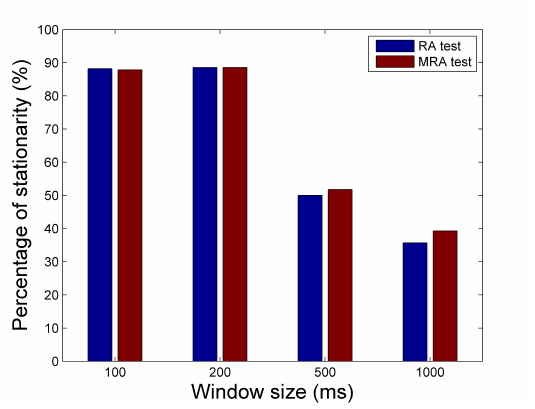
Figure 6. Average percentage of stationary EMG signals obtained from RA and MRA tests at various windows size